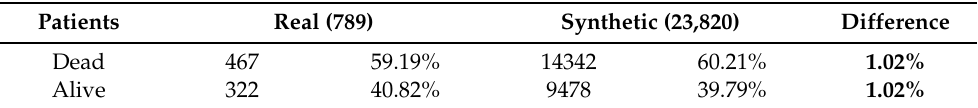
Table 6. Results of the ‘Recoded_Status’ features. In parentheses the number of dead or alive patients, that is, without counting the missing values.